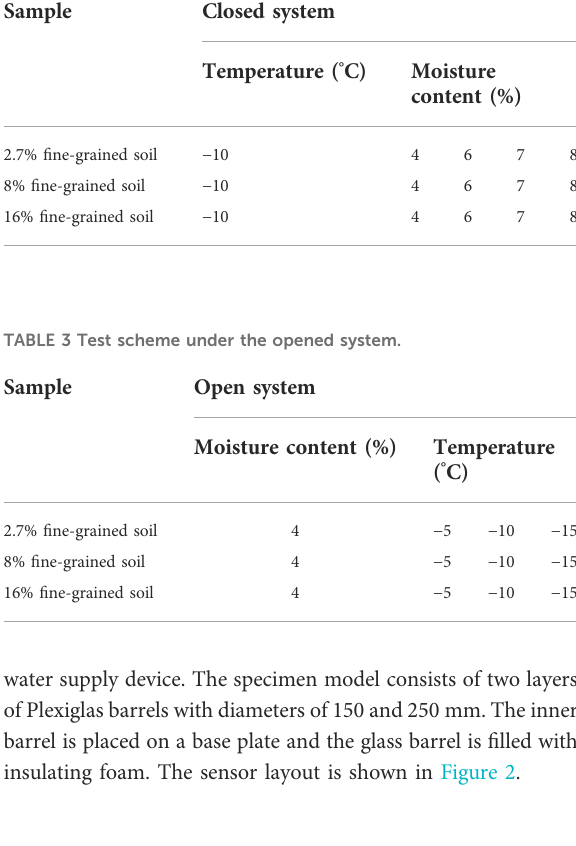
TABLE 2 Test scheme under the closed system.